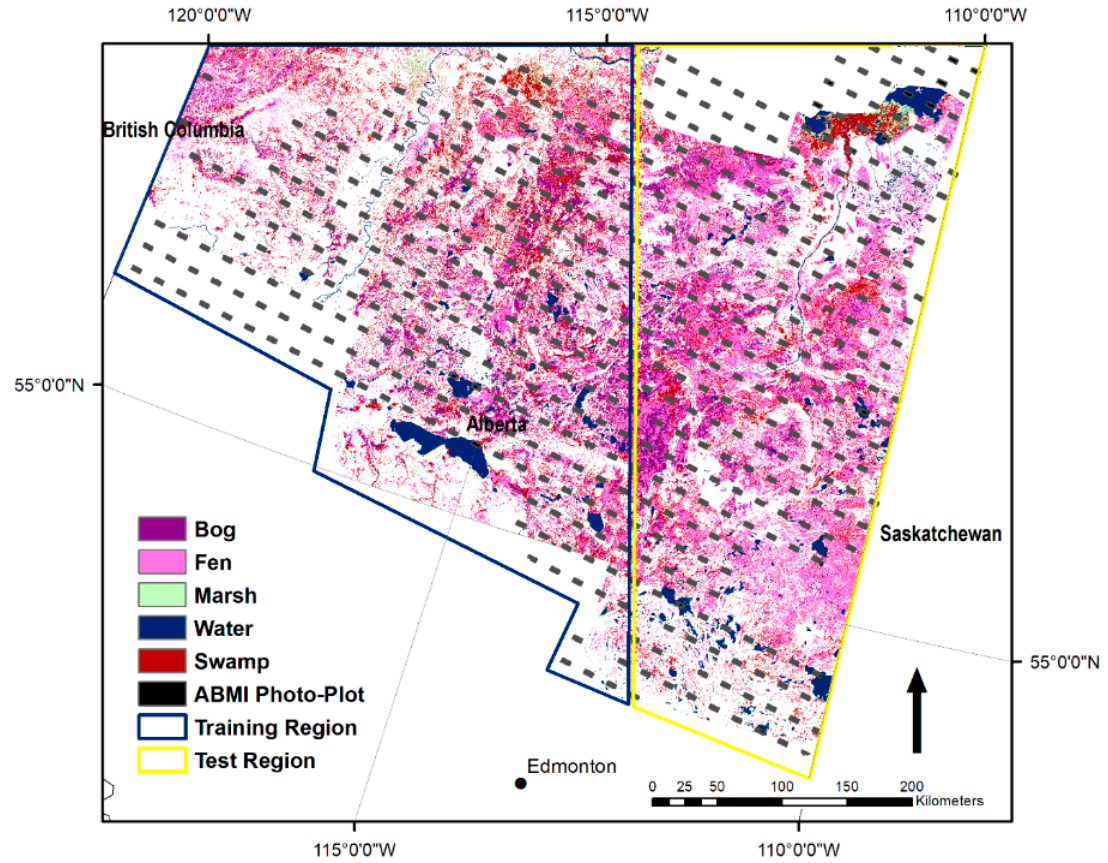
Figure 1. Study area showing the Alberta Merged Wetland Inventory (AMWI) wetland layer and ABMI_PP grid data sources used for training and testing.